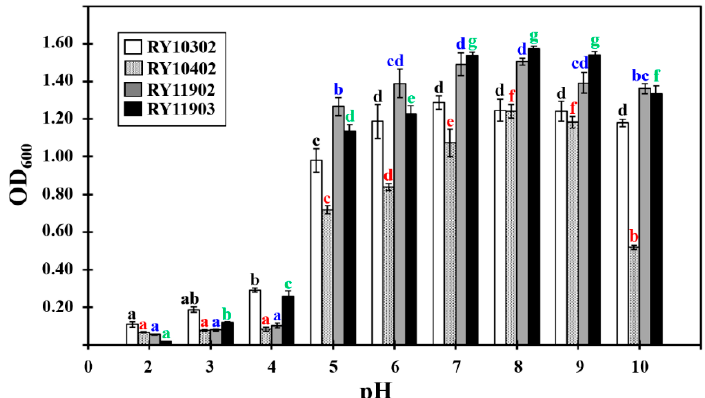
Figure 2. Effect of pH on the growth of four dye-decolorizing bacteria expressed as optical density measured at 600 nm. All experiments were performed in triplicate. Different letters with the same color on the top of SD bars indicate significant differences ( p < 0.05).